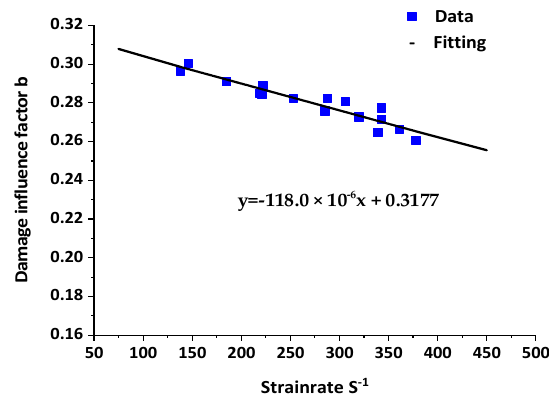
Parameters a and b were the damage in fl uence factors in Equation (7), respectively. The damage in fl uence factor a was a fi xed value of 0.0916. According to the fi tt ing results of parameters by the experimental data, the relationship between damage in fl uence factor b and di ff erent strain rates 𝜀(cid:4662) was established (Figure 7). b decreased with an increase in strain rate 𝜀(cid:4662) , indicating the weakening in fl uence of damage on the stress–strain relationship. Figure 7. Fi tt ing results of damage influence factor b and strain rate 𝜀(cid:4662) . Figure 7. Fitting results of damage influence factor b and strain rate